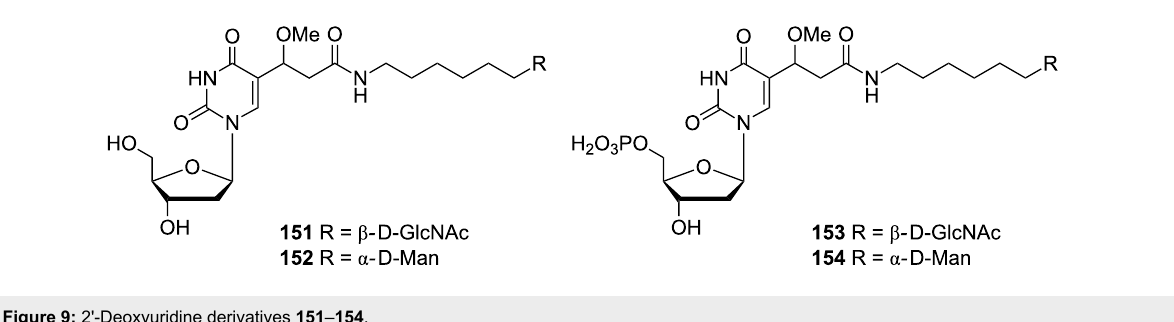
the reaction with TBAF. Finally, the 5'-hydroxyl groups were tritylated and the 3'-hydroxy group converted to the corres- ponding phosphoramidite 150 . The resulting phosphoramidite was incorporated into a 12-mer oligodeoxynucleotide via auto- mated solid-phase